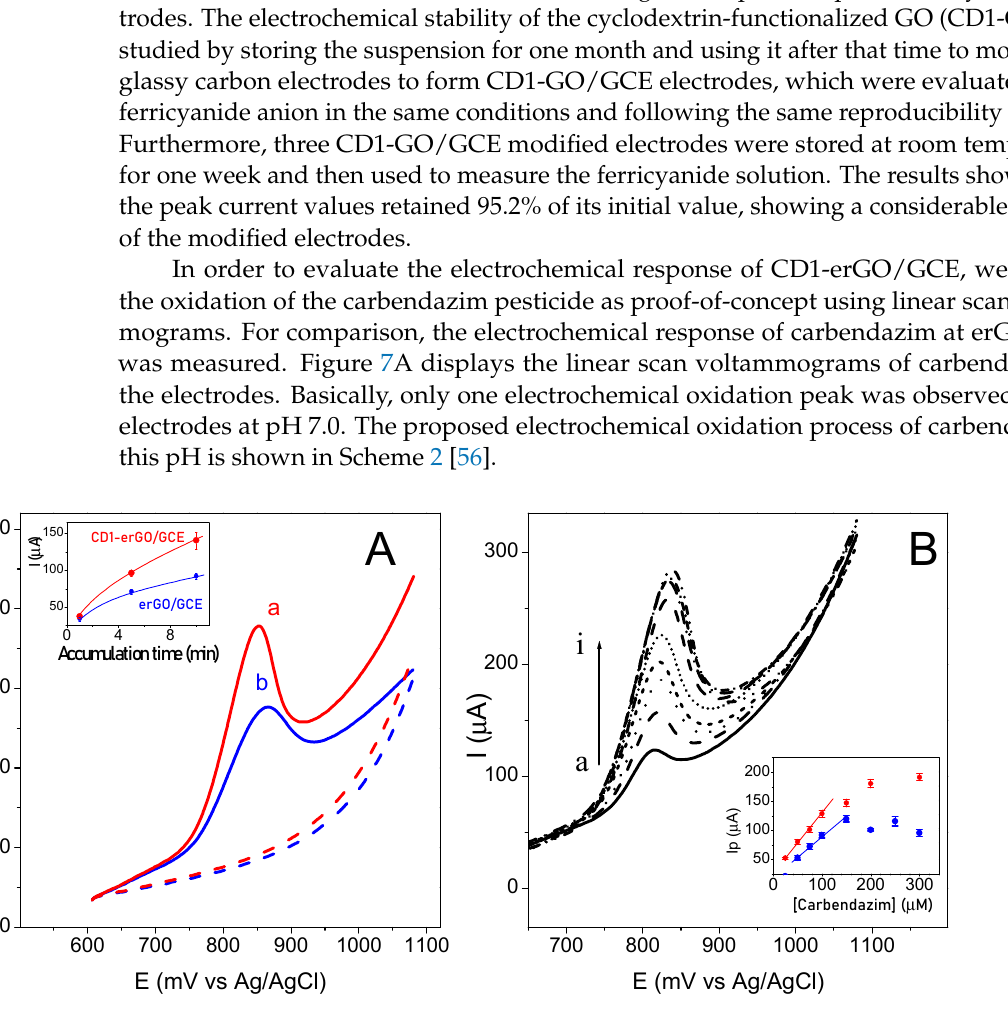
Figure 7. ( A ): Linear scan voltammograms obtained for 0.1 mM carbendazim in 0.1 M PBS (pH 7.0) at erGO/GCE (a) and CD1-erGO/GCE (b) using an accumulation time of 10 min. Baseline is shown as a dotted line in each case. Inset: Influence of the accumulation time of carbendazim at erGO/GCE (blue) and CD1-erGO/GCE (red) on the carbendazim oxidation peak current. ( B ) Linear scan voltammograms obtained for carbendazim at CD1-erGO/GCE using an accumulation time of 10 min. Carbendazim concentrations ranged from 25 to 400 µ M (named from a to i). Inset: Effect of carbendazim concentration at erGO/GCE (blue) and CD1-erGO/GCE (red) on the carbendazim oxidation peak current using an accumulation time of 10 min. Supporting electrolyte 0.1 M phosphate buffer solution, pH 7.0. Scan rate: 0.050 V s − 1